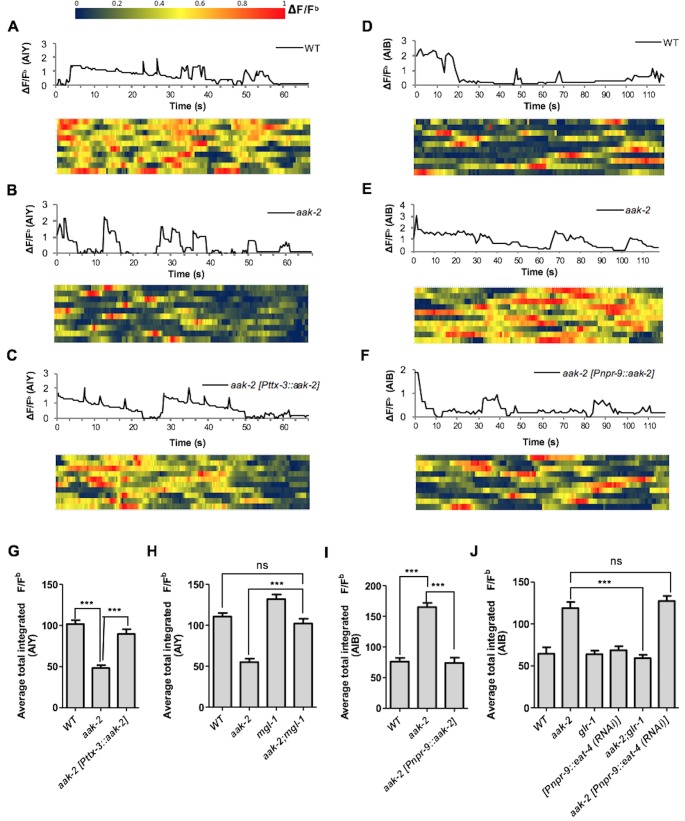
AMPK regulates AIB and AIY neuronal activity.(A,B,C,D,E,F) A sample ΔF/Fb plot showing spontaneous changes in the AIY and AIB neuronal activity in starved individuals during the course of a 65 and 120 s imaging window, respectively. These plots are the basis of the data in G, H, I and J. The heatmaps show normalized G-CaMP1 and G-CaMP3 traces in AIY and AIB, respectively in multiple animals. (G) The average total integrated fluorescence intensity (ΔF/Fb) over the course of a 65 s window. AIY neuronal activity is reduced in starved aak-2 mutants and this reduction in the AIY neuronal activity is restored by targeted expression of aak-2 within the AIY interneurons using the AIY-specific [Pttx-3::aak-2] transgene (n>10). (H) Removal of mgl-1 in aak-2 mutants rescues the reduced AIY neuronal activity observed in starved aak-2 mutants (n>10). (I) The average total integrated fluorescence intensity (ΔF/Fb) in AIB is increased upon removal of aak-2 in starved animals, and this increase is reversed by expression of aak-2 within the AIB using the AIB-specific [Pnpr-9::aak-2] transgene (n>10). (J) Removal of glr-1, but not eat-4, restores the increased AIB neuronal activity in starved aak-2 mutants (n>10). Error bars represent ± SEM (one-way ANOVA ***p<0.0001).DOI:
http://dx.doi.org/10.7554/eLife.16349.01710.7554/eLife.16349.018Figure 4—source data 1.Calcium imaging in the AIB and AIY interneurons in WT, aak-2, mgl-1, glr-1 and eat-4 and double mutants.DOI:
http://dx.doi.org/10.7554/eLife.16349.01810.7554/eLife.16349.019Figure 4—source data 2.Calcium imaging in freely WT and aak-2 behaving animals.